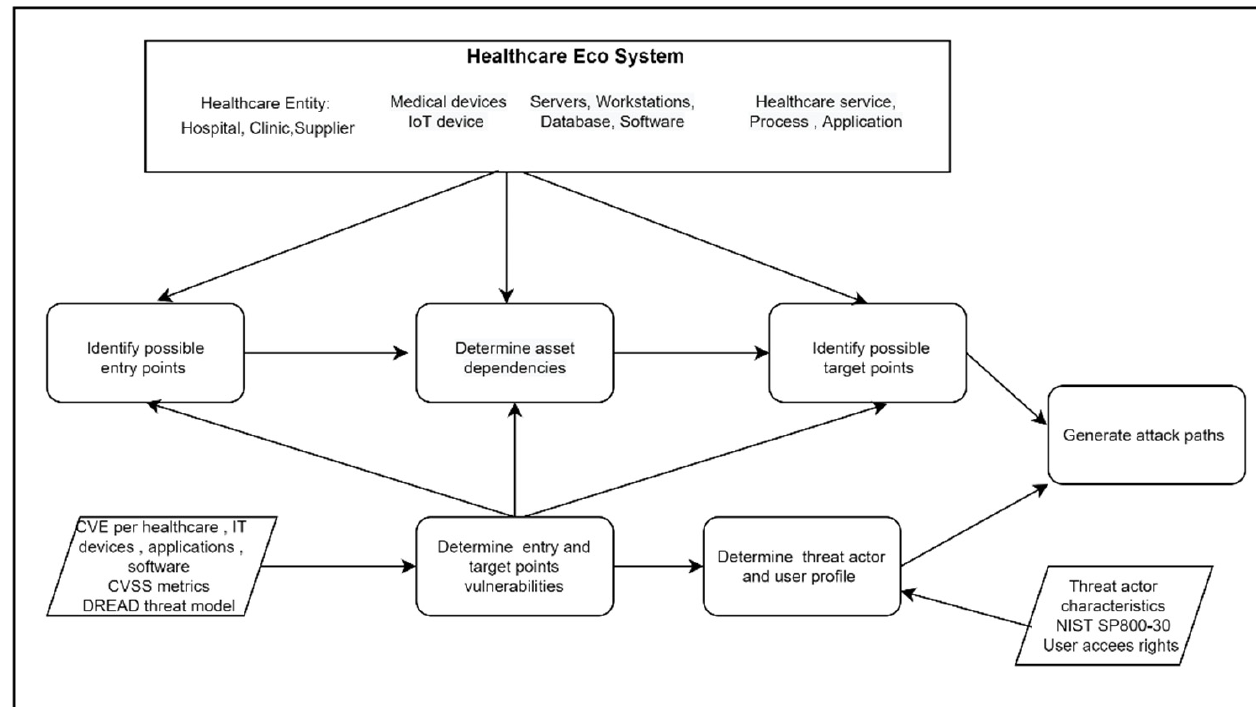
Figure 3. Attack path generation and analysis process.